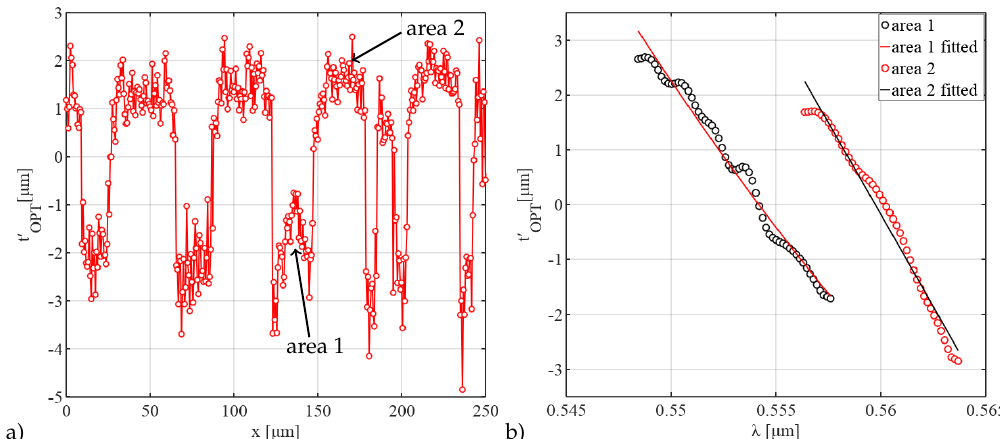
Figure 5. Results of the measured RDOT ( a ) spatially resolved along one sample dimension of a lithographically structured photoresist layer with structures having a nominal pitch of 50 µ m on a Si-substrate at a wavelength of 557 nm and ( b ) mean values and fitted data for two marked areas with different degrees of cross-linking over a spectral